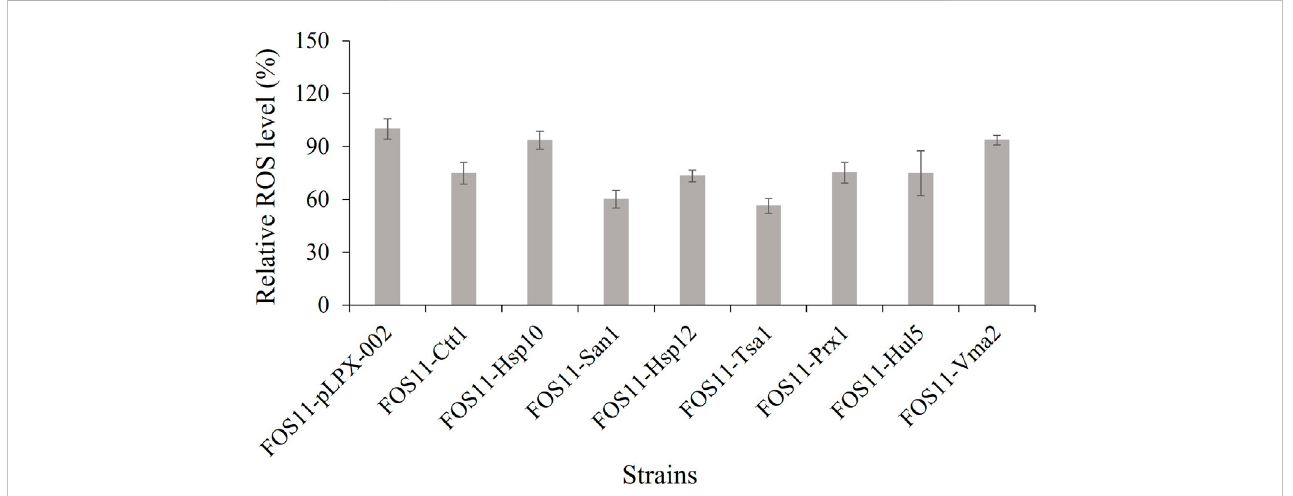
Comparison of the intracellular ROS level of engineered and control strains during fermentation at 35 ° C. Data represent the mean ± SD of three biological replicates.